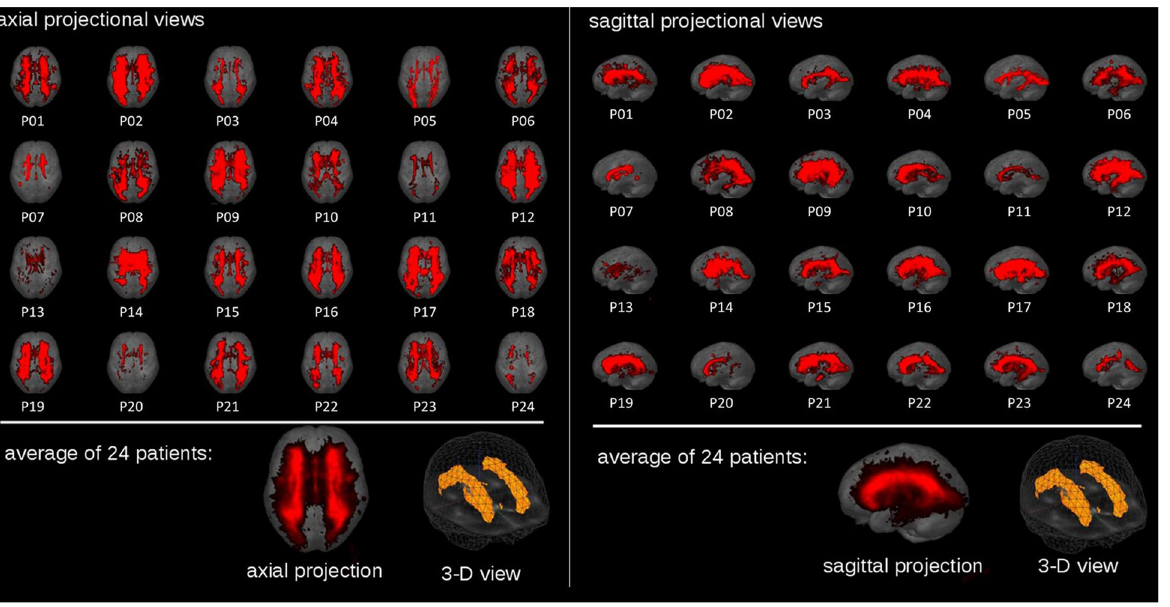
Fig. 2 White matter hyperintensities (WMH) for 24 patients detected from FLAIR-MRI-recordings in axial (left) and sagittal (right) projectional views. For comparability, individual results were normalized to the Montreal Neurological Institute (MNI) coordinate frame and displayed on the same morphological background (segmented averaged